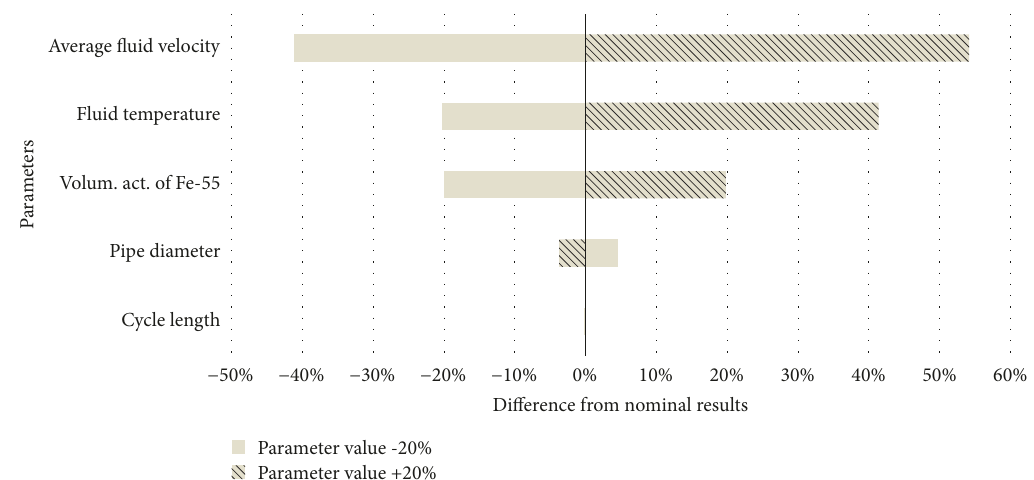
Figure 7: A tornado diagram presenting sensitivity analysis results of SP-HPR-4 component’s contamination with